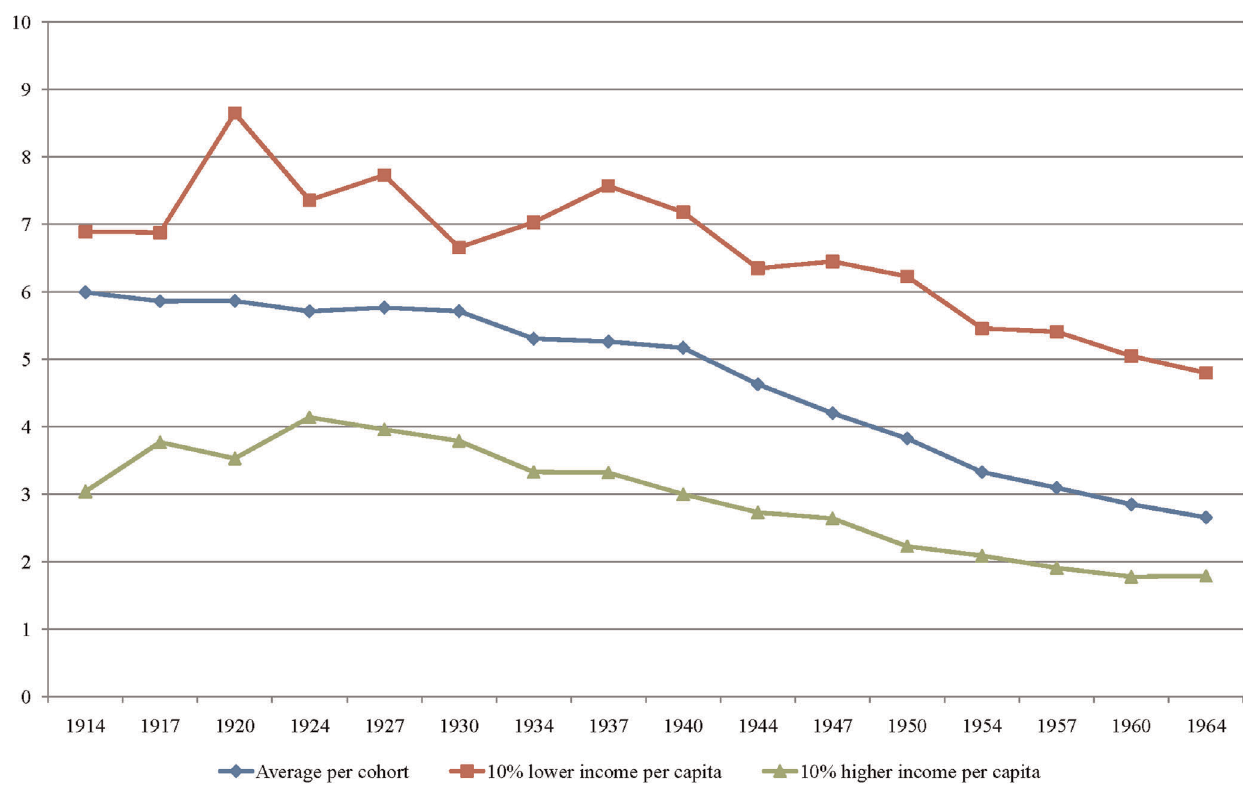
Figure 3. Number of Children and Income Centile by Cohorts (1914–1964). Source: PNAD 1992 to 2009. Author’s tabulation.